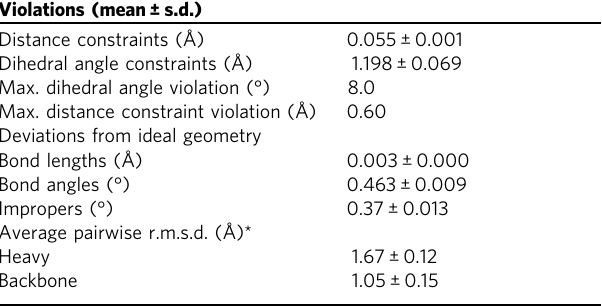
Table 2 Summary of re fi nement and validation statistics